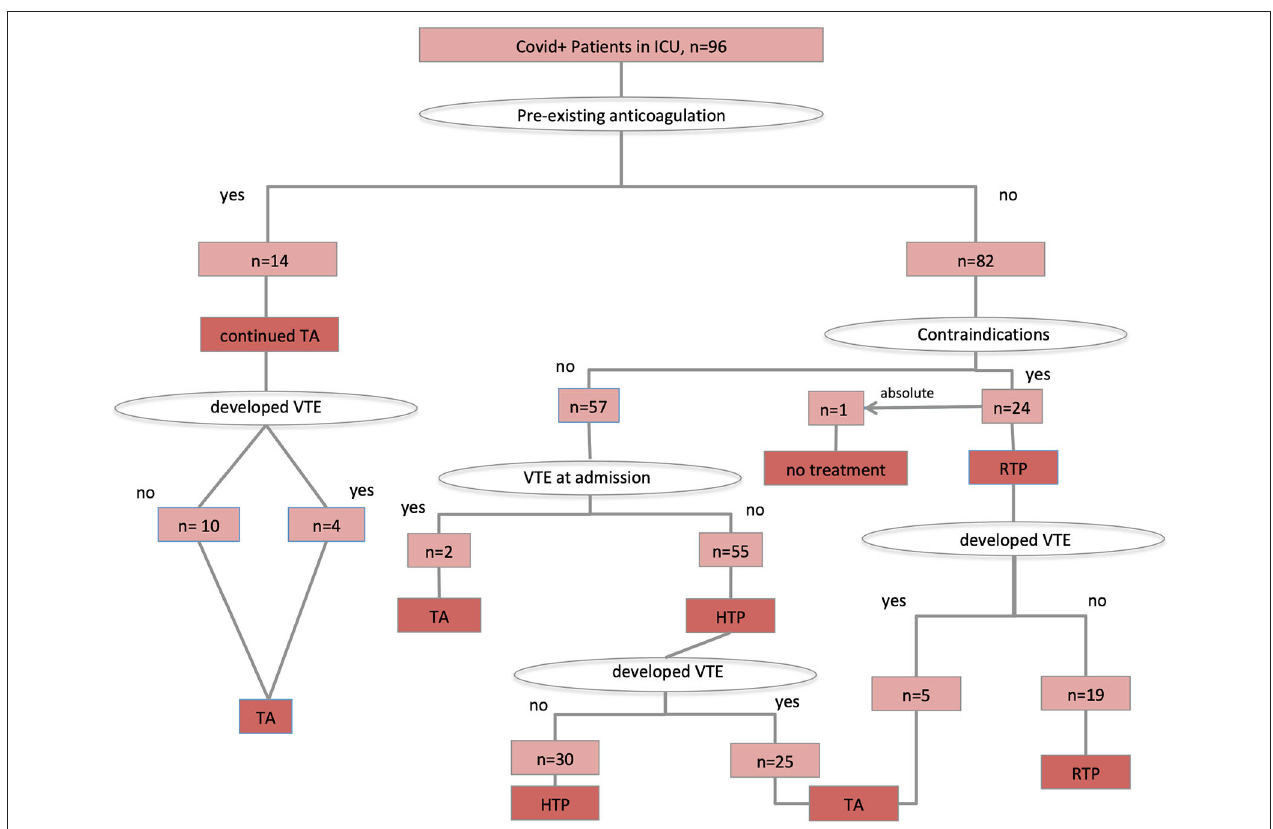
FIGURE 1 | Antithrombotic treatment protocol application. TA, therapeutic anticoagulation; HTP, higher-intensity thromboprophylaxis; RTP, regular-intensity